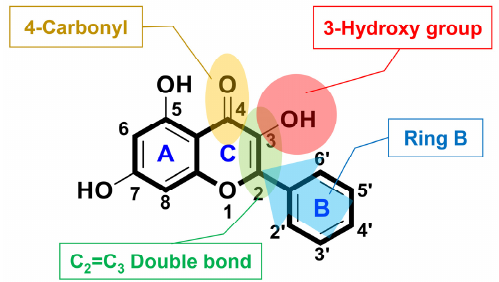
Figure 13. Structure of galangin and active site of antioxidant effect.